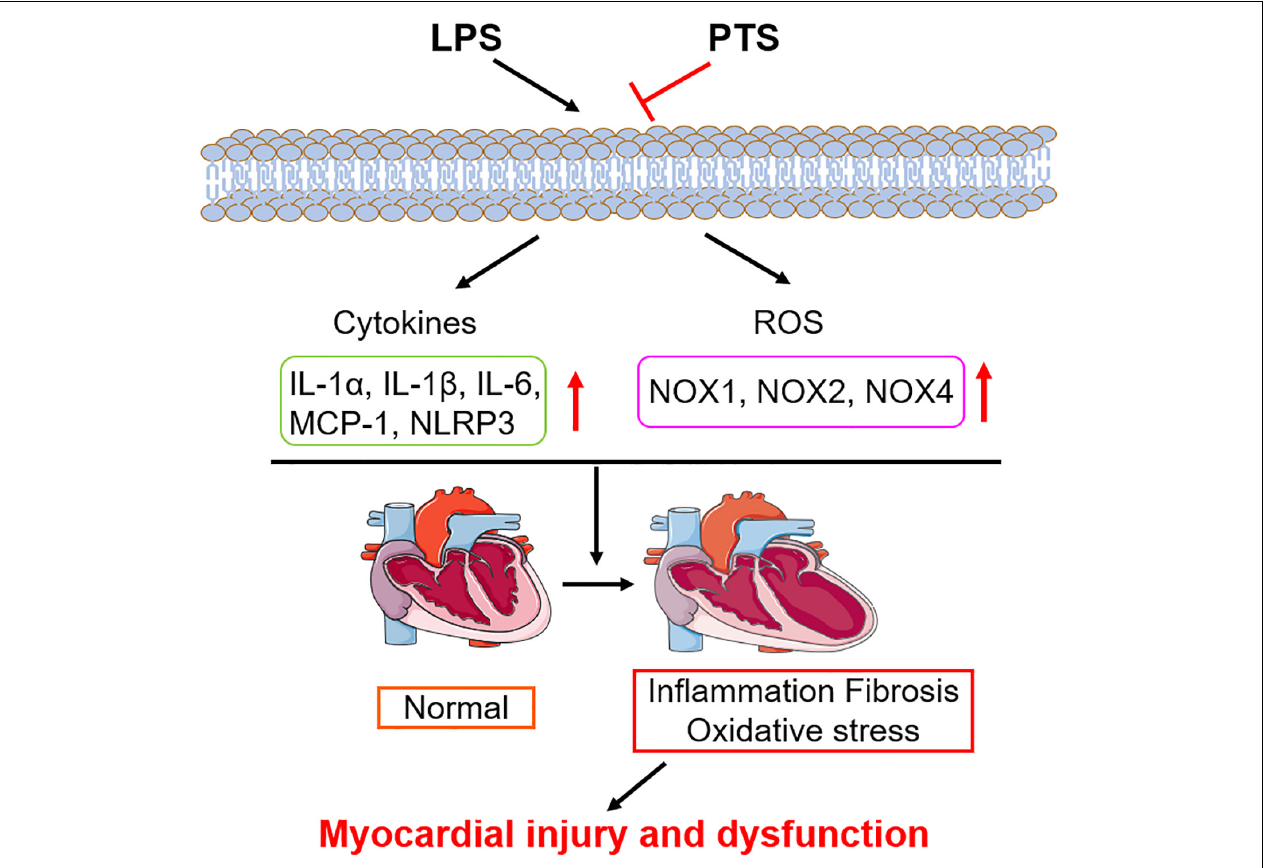
FIGURE 7 | Schematic diagram of the mechanism: pterostilbene inhibits LPS-induced myocardial